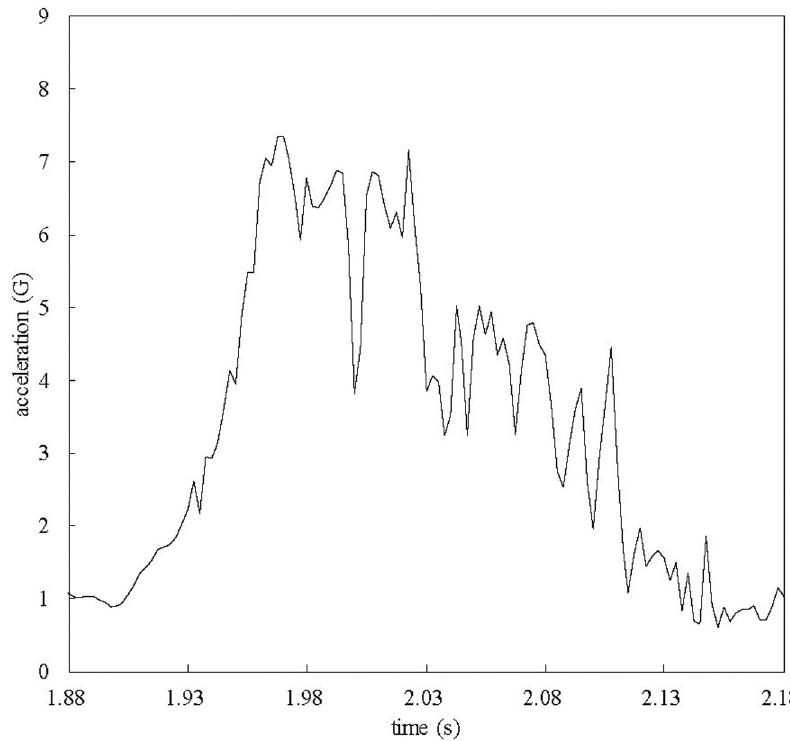
Fig 6. Time series of acceleration before and after the collision in deployment 1. The horizontal axis shows the time elapsed since the wave reached the test body.